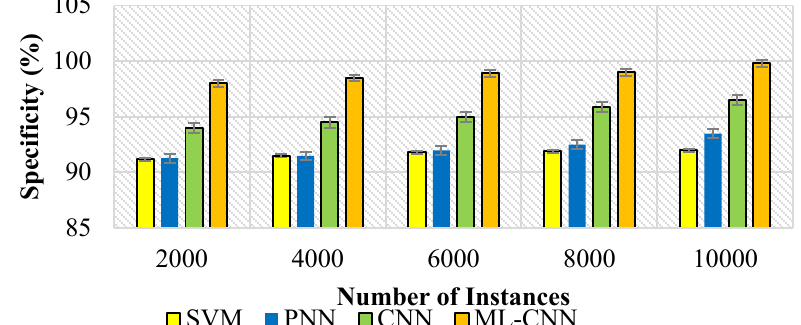
Figure 9. Specificity vs. number of instances .